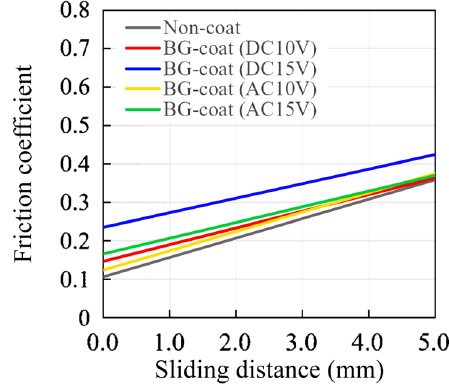
Figure 5. Frictional forces obtained by the progressive load scratch test.